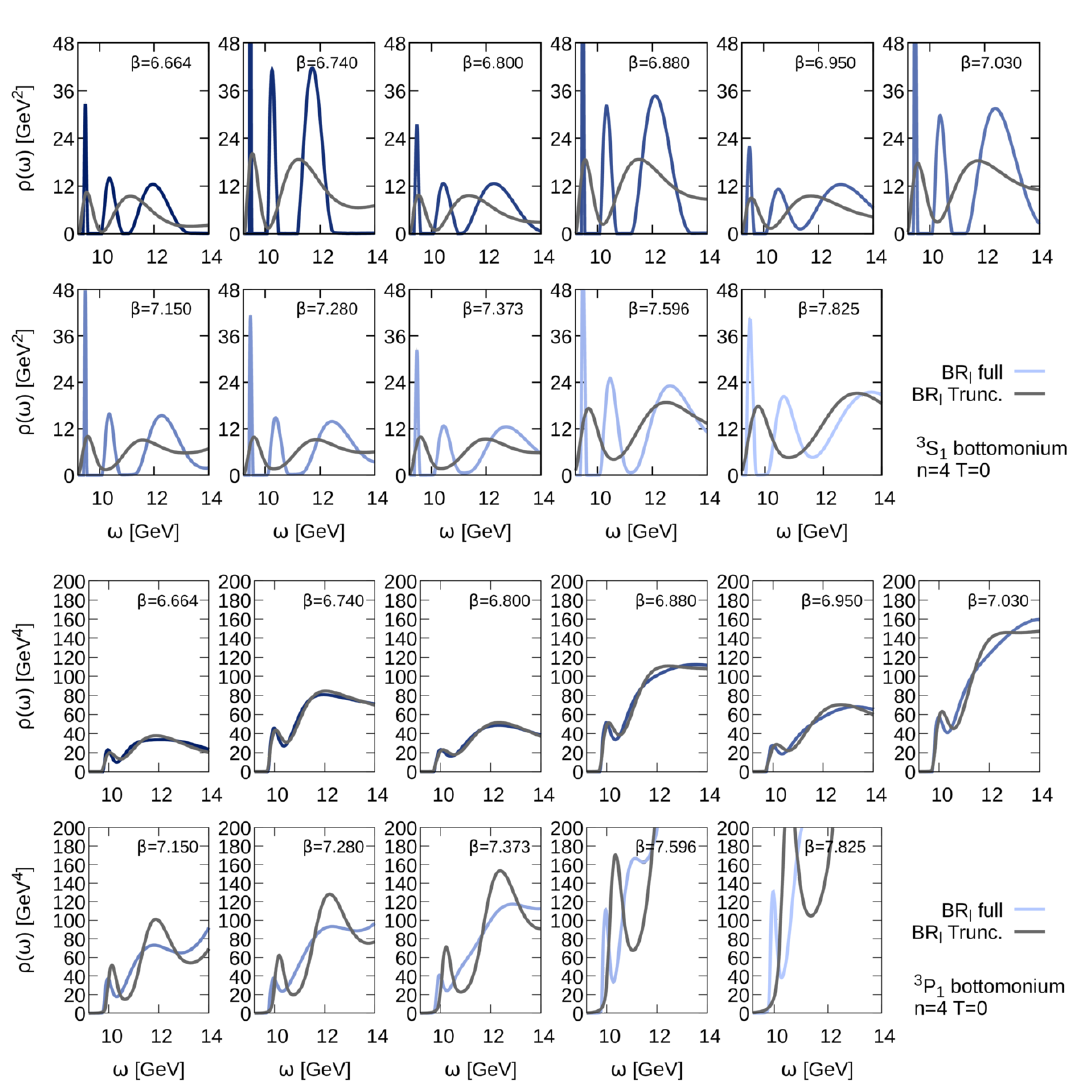
Figure 13 . In(cid:13)uence on the smooth BR reconstruction from a truncation of the low-temperature simulation data to the same (cid:28) max =a (cid:28) = 12 Euclidean time extent available at (cid:12)nite temperature. The spectra shown here correspond to the 3 S 1 (top) and 3 P 1 channel of bottomonium with the full reconstruction given by colored solid lines, while the result after truncation is given by the gray solid